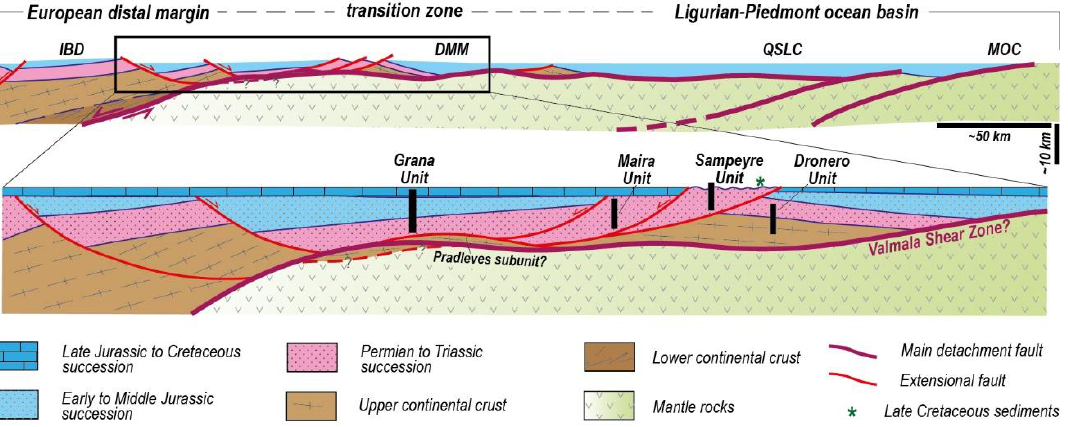
Figure 10. Paleogeographic reconstruction at the Late Jurassic time and detail of the transition zone between the European distal margin and the LPBO (IBD: Internal Briançonnais Domain; DMM: Dora Maira Massif; QSLC: Queyras Schistes Lustrès Complex; MOC: Monviso meta-ophiolite Complex) (modified after [8]).